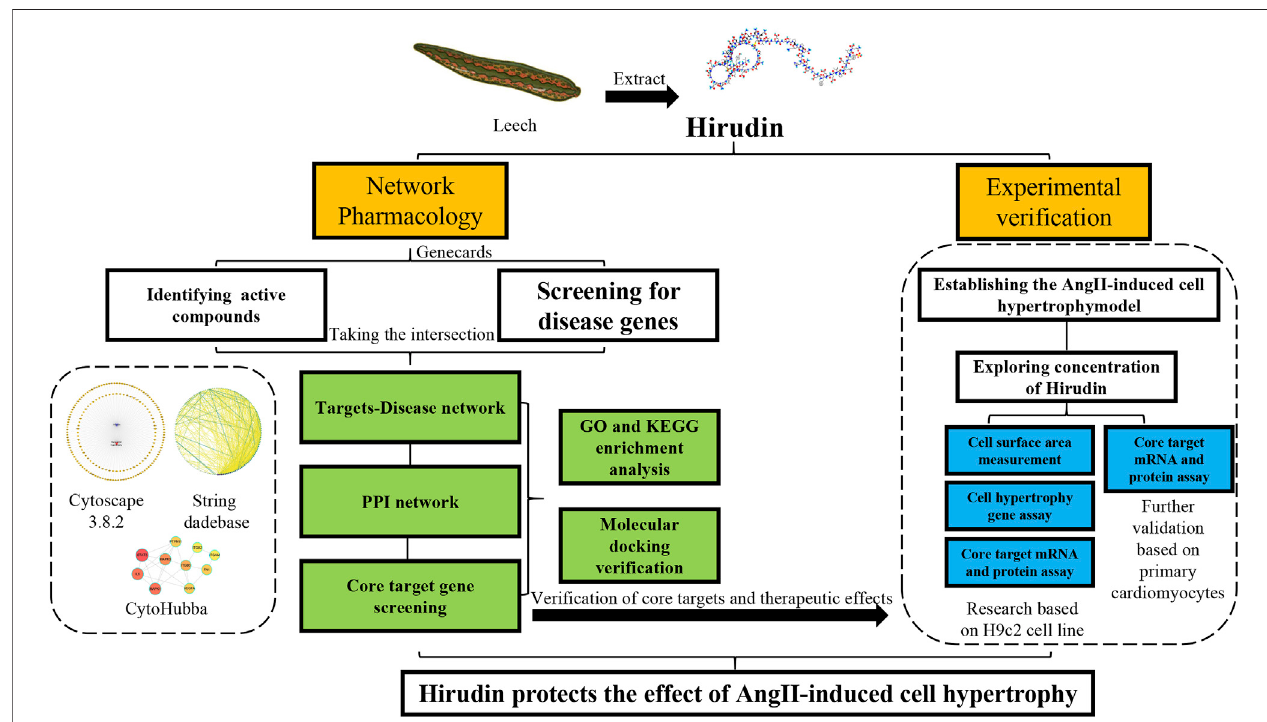
FIGURE 1 | Work fl ow for dissecting the network pharmacology and in vitro experimental veri fi cation reveals the mechanism of the hirudin in suppressing myocardial hypertrophy.